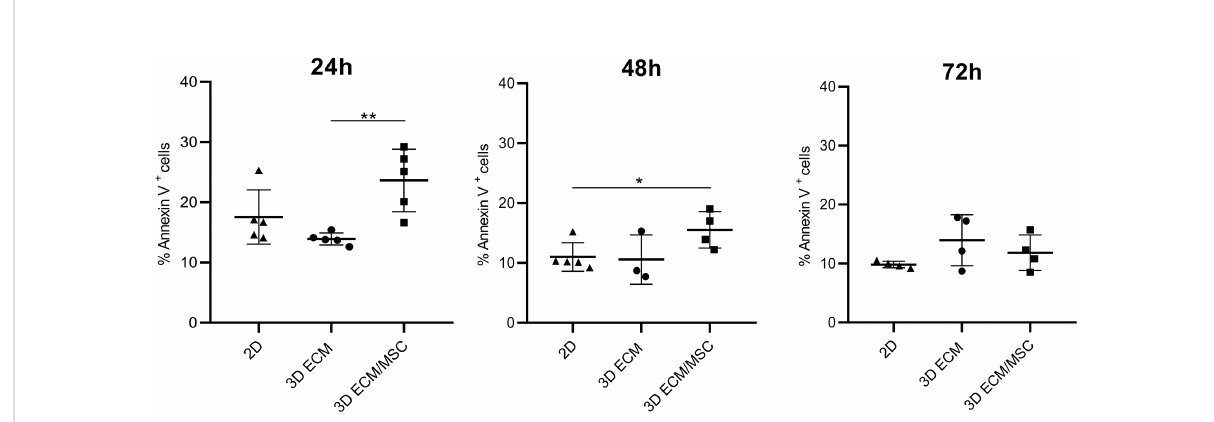
FIGURE 8 Annexin V/PI cyto fl uorometric assay of OCI-LY18 cells harvested from the model after 24, 48, and 72 h of incubation. 2D represents a control standard culture; 3D ECM indicates the model constituted by decellularized scaffold and OCI-LY18; 3D ECM/MSC indicates the scaffold recellularized also with primary MSC. The data reported correspond to the sum of Annexin V + /PI − and Annexin V + /PI + cells. Statistical analysis: non-parametric t -test. * p < 0.05; ** p <